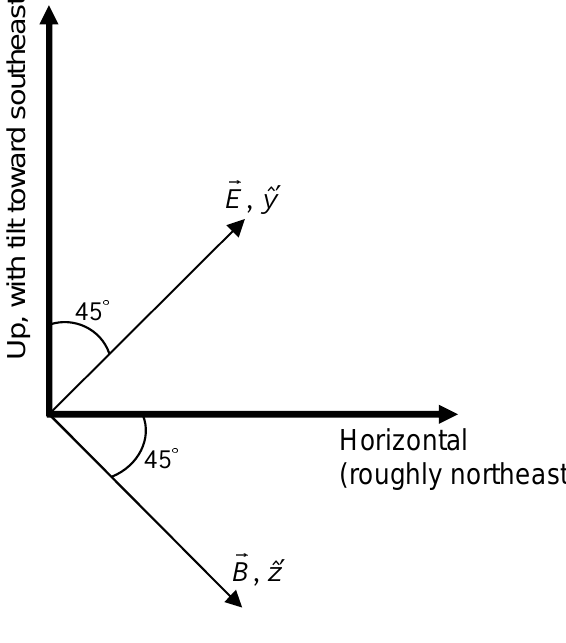
Figure 3: Axis orientation for Figure 4 through Figure 12. Fig. 3. Axis orientation for Fig. 4 through Fig. 12. The coordinate axes, E , and B , all lie in the planes of the